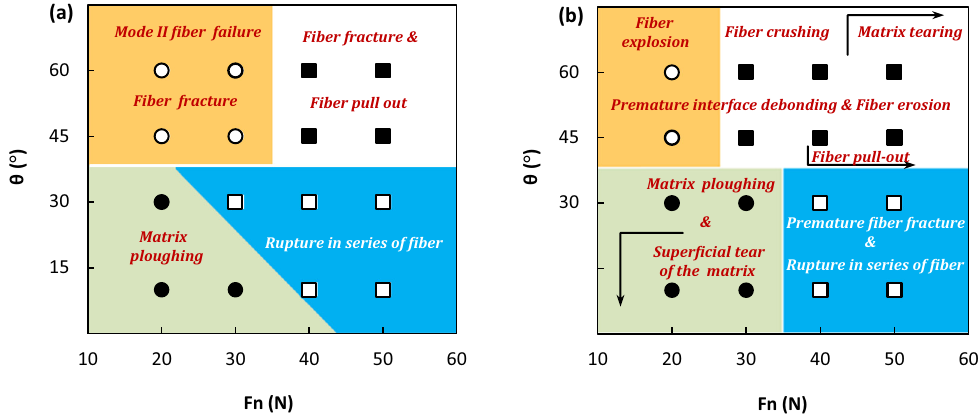
Figure 8: Wear maps obtained at ( a ) SST ⊥ and ( b ) SST // ( The back arrow points the start and the direction of the domination of wear mechanisms. )